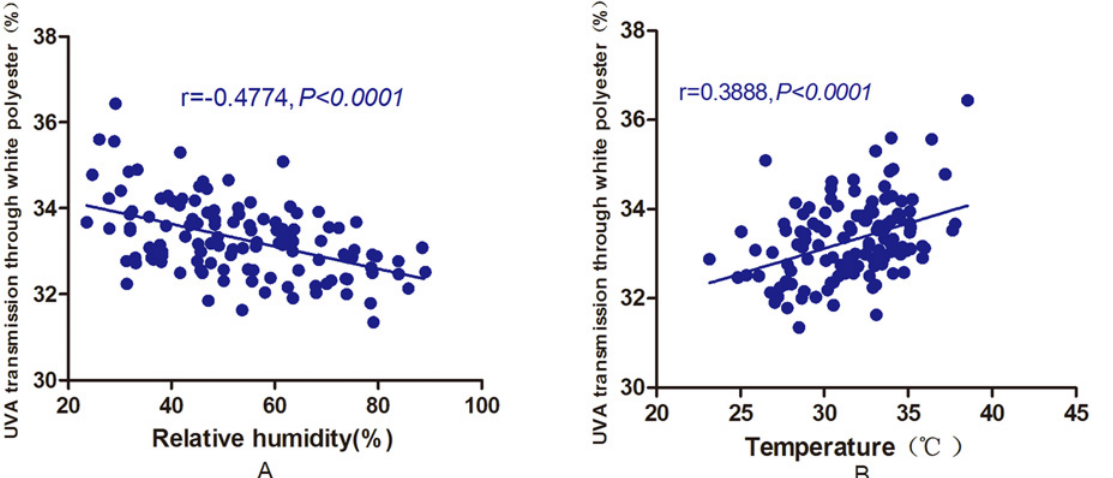
Fig 5. The relationship between environmental relative humidity and temperature and UVA transmission through white polyester. A: Pearson ’ s correlation analysis revealed a significant negative correlation between relative humidity and UVA transmission through white polyester (r = -0.4774, P < 0.0001). B: Pearson ’ s correlation analysis showed a significant positive correlation between temperature and UVA transmission through white polyester (r = 0.3888, P <